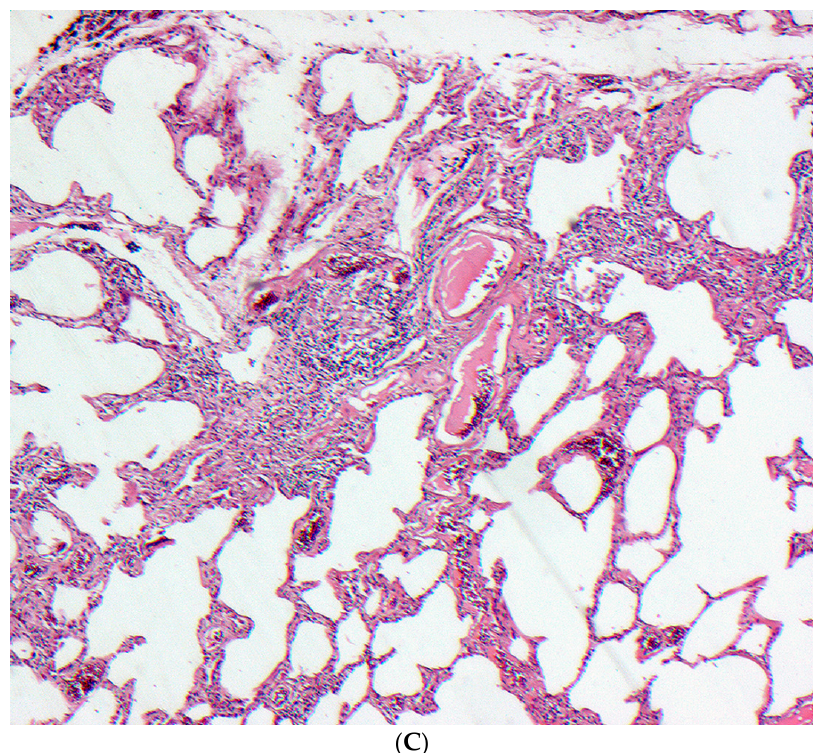
Figure 3. ( A – C ) A case of chronic hypersensitivity pneumonitis shows ( A ) areas of patchy subpleural dense fibrosis and ( B ) focal honeycomb change, typical of a pattern of usual interstitial pneumonia. ( C ) Rare peribronchiolar granulomas are also